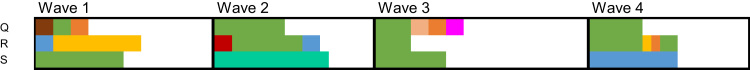
Examples of complicated or apparently random patterns. Each horizontal line is an individual. The waves are separated by vertical black lines. Each trip is one square, individually colour-coded and the length of the line corresponds with the number of commute trips made over one week. Each colour represents one modal combination. Orange = car only; green = bicycle only; blue = walk only; yellow = train only; and brown = bus only. The white colour indicates no trip was made. Full legend: see Appendix D. (For interpretation of the references to color in this figure legend, the reader is referred to the web version of this article.)